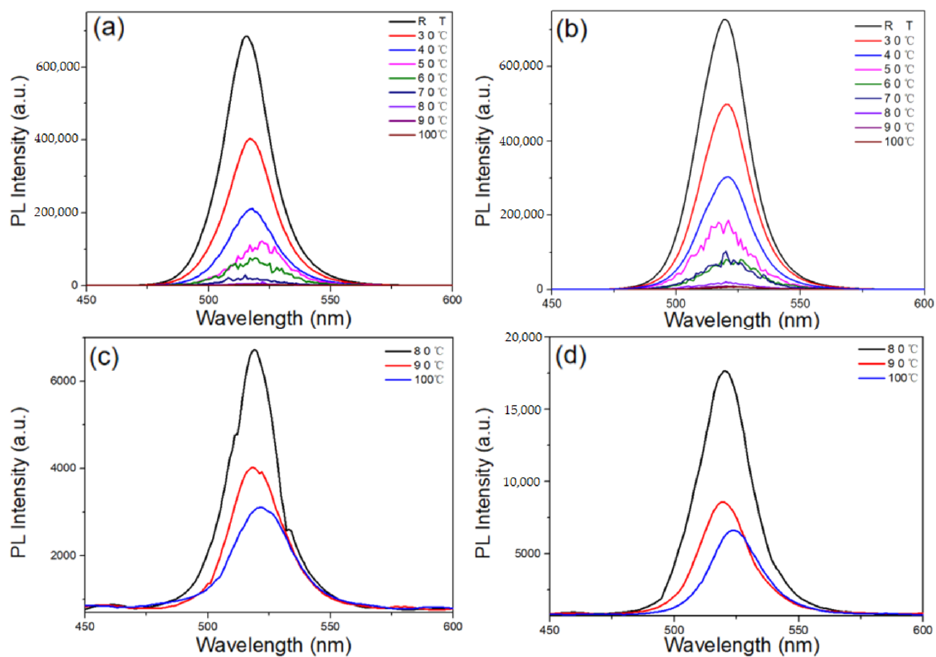
Figure 6. PL spectra of ( a ) pure CsPbBr 3 QDs and ( b ) SBA-15@CsPbBr 3 QDs from room temperature to 100 °C; PL spectra of ( c ) pure CsPbBr 3 QDs and ( d ) SBA-15 CsPbBr 3 QDs at 80, 90, and 100 °C. The PL spectra of the pure CsPbBr 3 QDs and SBA-15@CsPbBr 3 QDs with the